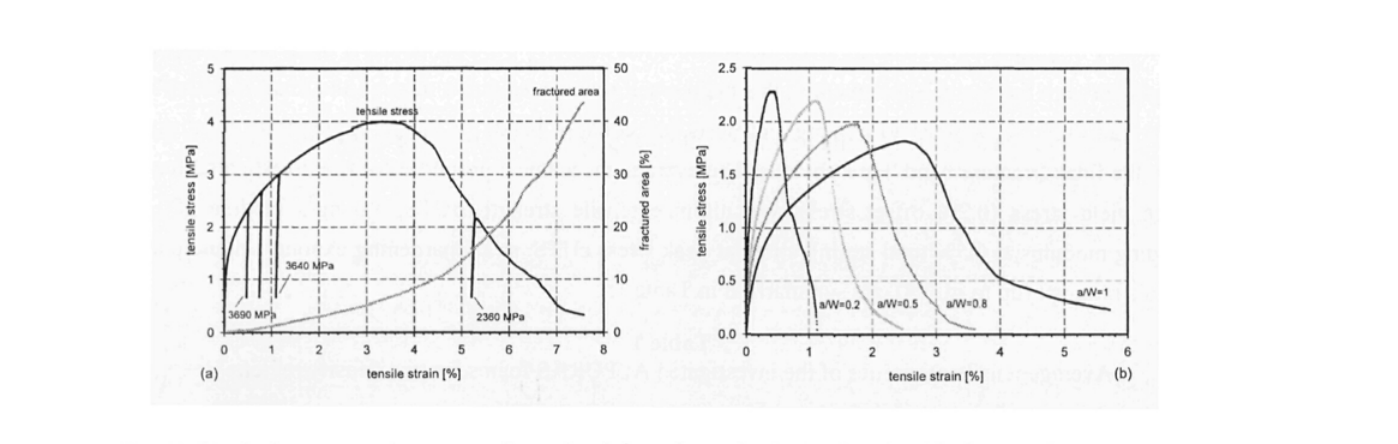
Fig. 2: Typical stress-strain curve of an aluminium foam (p=0.40 g/cm3) with fractured area percentage determined by potential drop and unloading module indicated (a), and stress-strain response of notched foam specimens (p=0.25 g/cm3) with different notch depth ratios (b). 0.2 to 0.5%